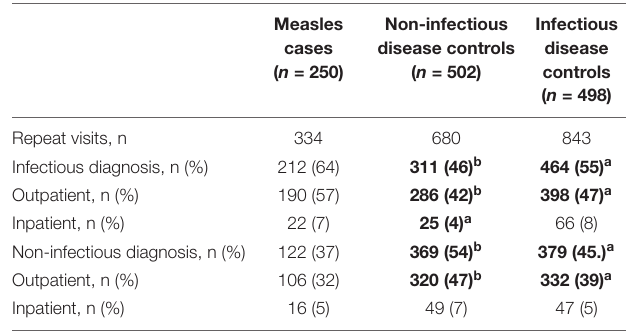
TABLE 3 | Number of repeat visits to the emergency